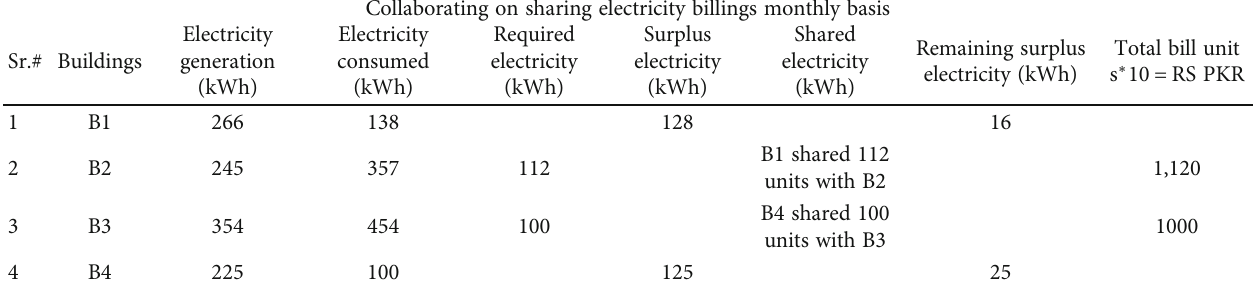
Figure 5: Building ’ s behavior capacity. Table 1: Collaborating on sharing electricity